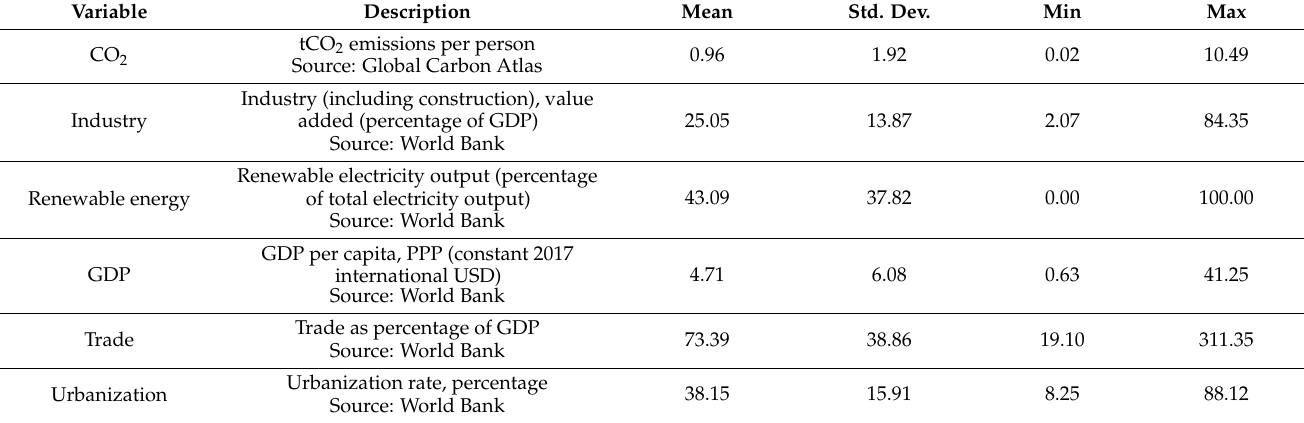
Table 1. Summary statistics.